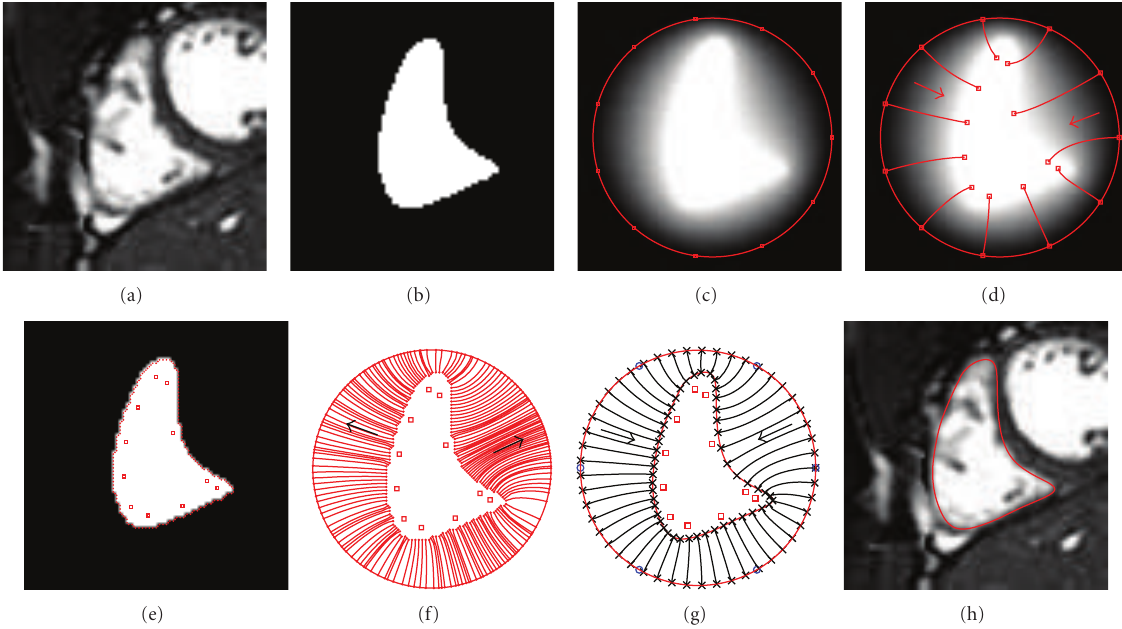
Figure 2: Mesh generation summary. The input image (a) is segmented into the object and background, resulting in a binary image (b). A sphere enclosing the object is centered at the object barycenter (c). The sphere is uniformly sampled with the number of points equal to the number of singularities. The binary image is resampled with isotropic voxels and the Laplace equation is numerically solved between the sphere (boundary condition of 0) and the object (boundary condition of 1). The solution of the Laplace equation is encoded in the gray levels in (c) and (d). The binary object is eroded, and the points are propagated from the sphere to the eroded object in the direction of the gradient of the Laplace equation solution to define the singularity locations, shown as red squares in (d) and (e). Boundary points, specified as midpoints for each pair of neighboring voxel, where one voxel is in the object and the other is in the background, are shown as red dots in (e). The singularity locations as well as the boundary points are used to specify the analytic solution of the Laplace equation. The boundary points are propagated in the negative gradient direction of the solution of the Laplace equation from the object boundary to the sphere (f). Their values of the underlying solution of the Laplace equation are interpolated at the sphere to the define the stopping function. The number of degrees of freedom of the stopping function is defined by the number of control points, which are shown as blue circles in (g). An approximately uniform mesh is generated on the sphere. The vertices of the mesh on the sphere, shown as black crosses in (g), are propagated from the sphere in the direction of the gradient of the solution of the Laplace equation until the value of the underlying solution of the Laplace equation is equal to the corresponding value of the stopping function. The propagated mesh nodes define the final mesh, shown in (h). Figures (a)–(h) are two dimensional for illustration purposes, while the method is three dimensional.